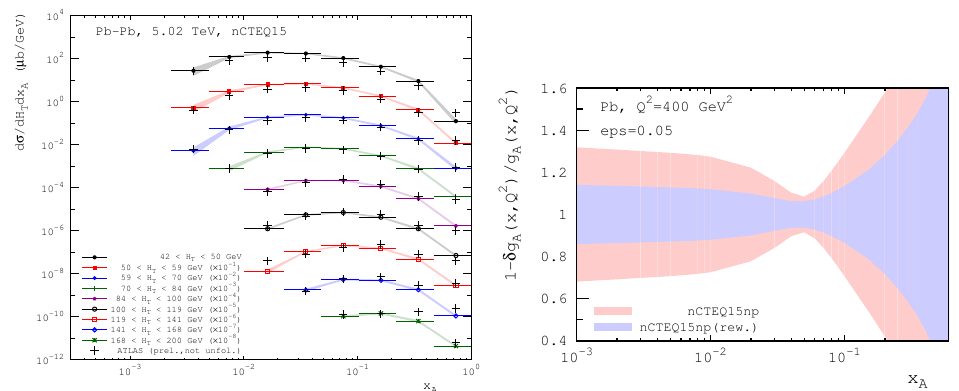
Figure 2: (Left) NLO QCD results for the cross section of dijet photoproduction in (cid:112) = 5.02 TeV as a function of x s Pb-Pb UPCs at NN The crosses are the ATLAS data points extracted from [ 15 ] . (Right) The relative uncertainty bands of the nCTEQ15np gluon distribution in Pb at Q 2 = 400 GeV 2 as a function of x before (outer shaded band) and after (inner shaded band) the A re-weighting assuming a 5% error on the pseudo-data [ 10 ]